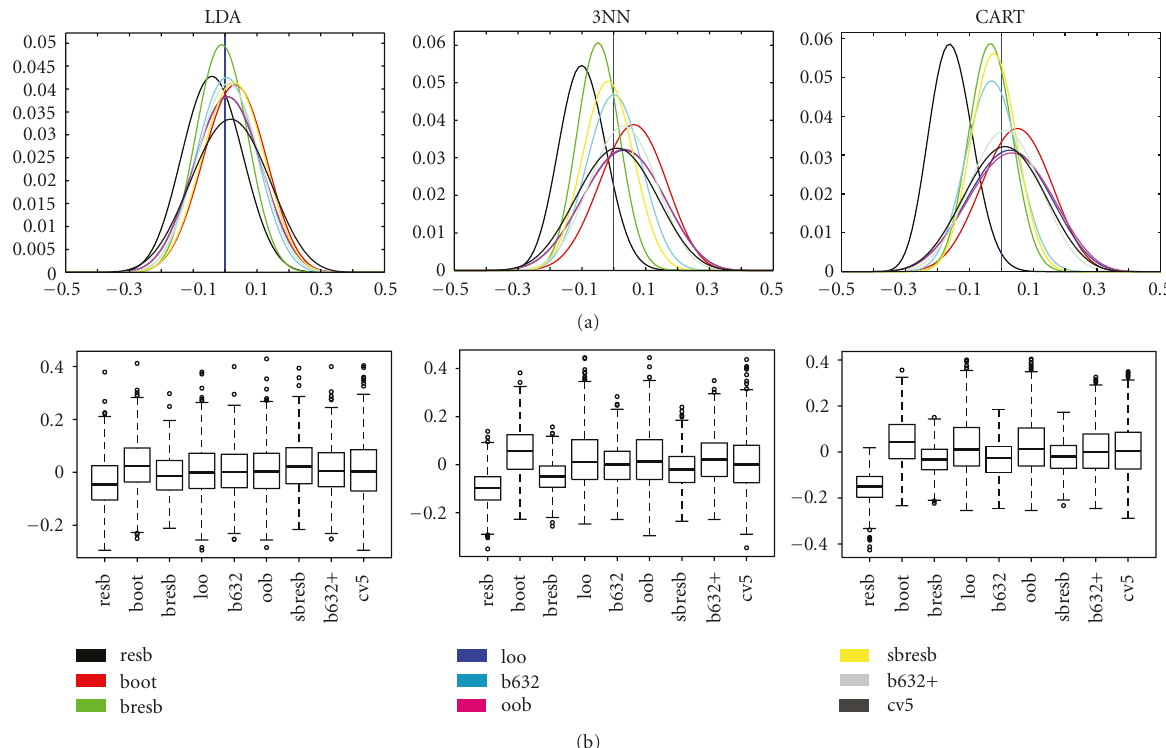
Figure 5: Empirical deviation distribution (a) and box plots (b), for breast cancer gene expression data, sample size n = 20, and dimensionality p = 2, with di ff erent base classification